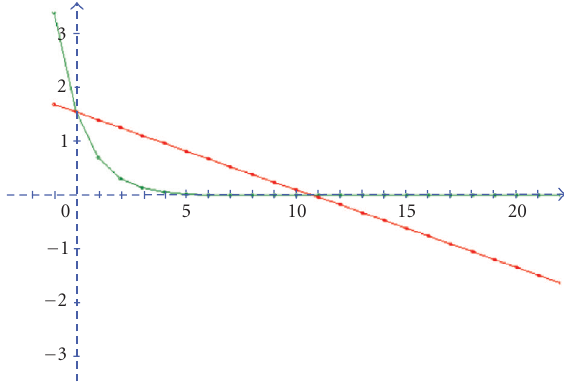
Figure 3.8. Behavior of x n and y n in the point W .